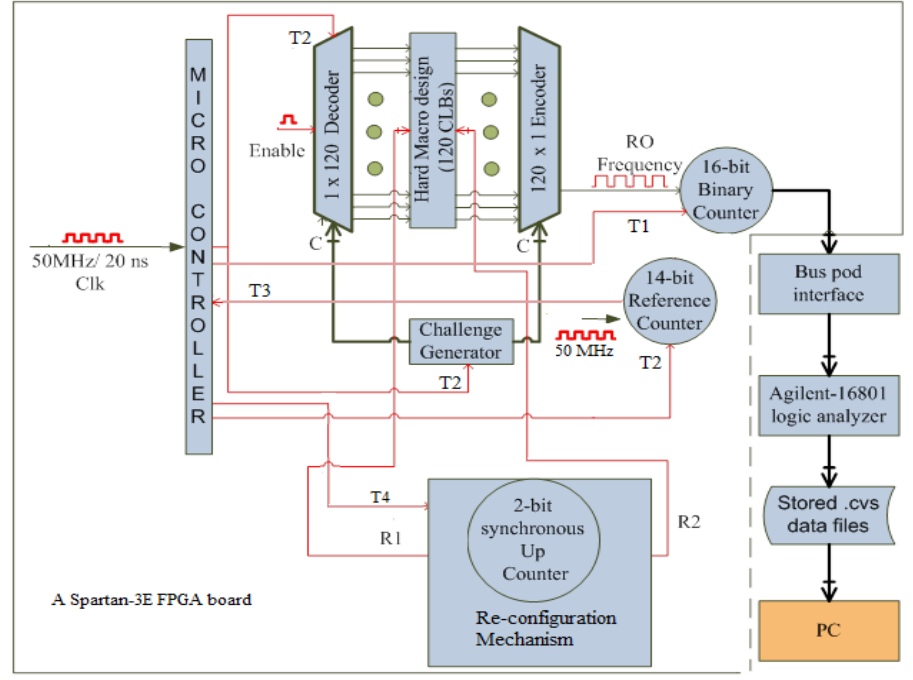
Figure 8. A complete circuit design of the proposed d-ROPUF technique for an FPGA area (120